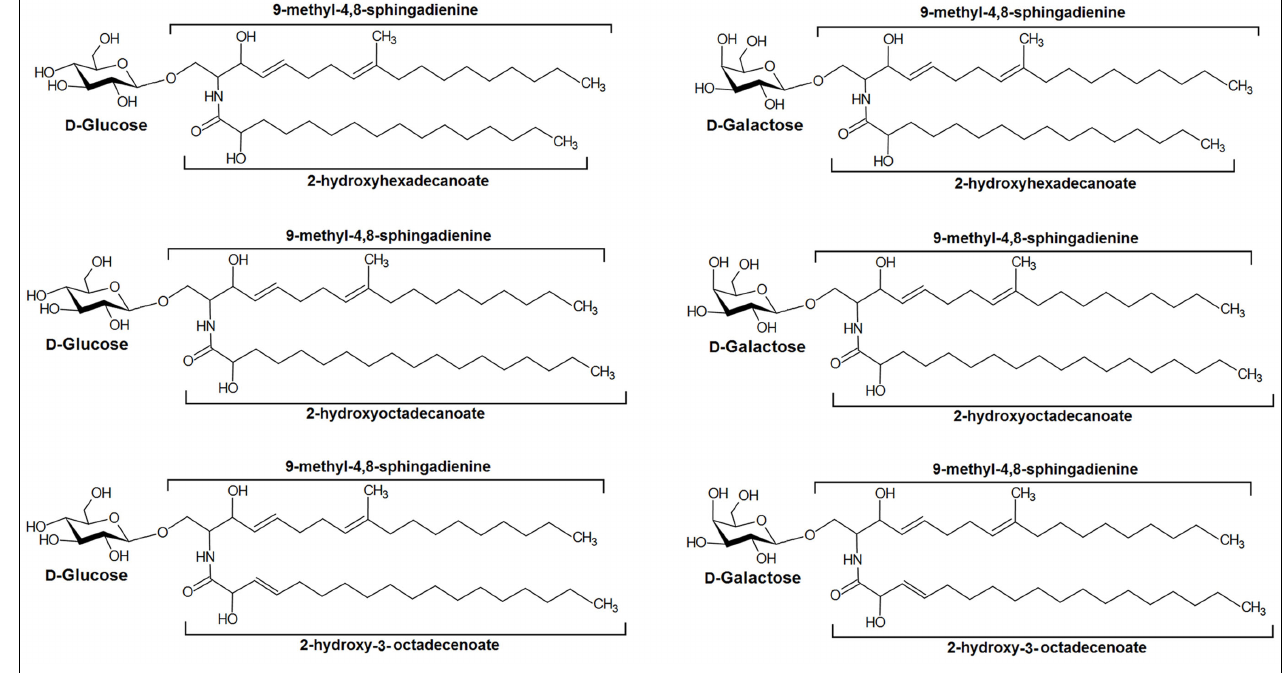
Frontiers in Microbiology | Fungi andTheir